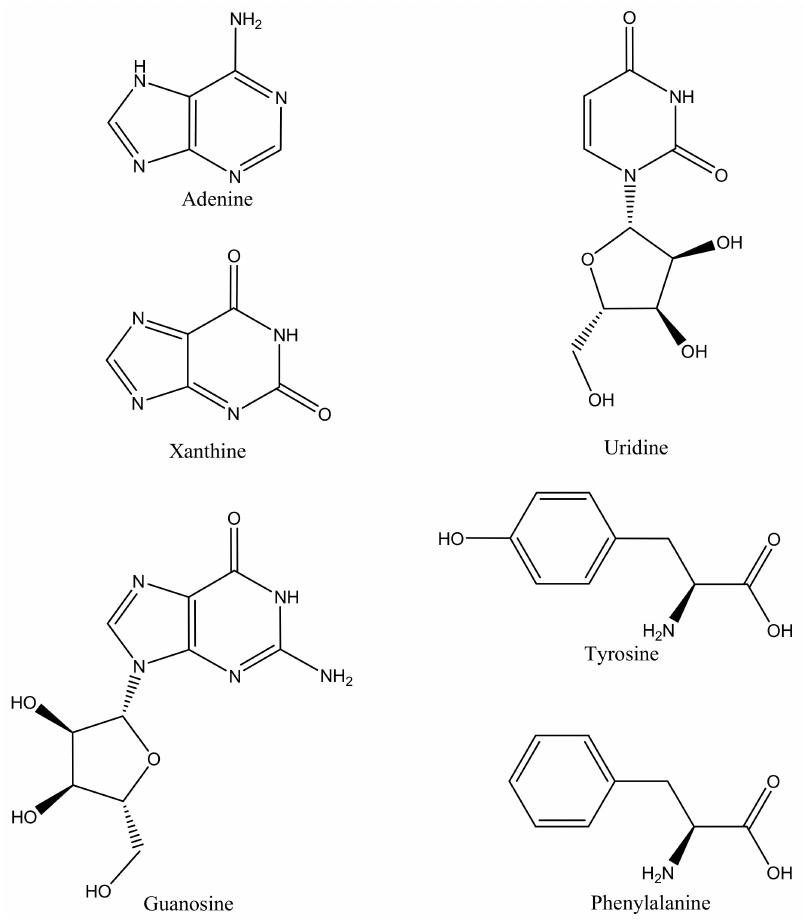
Figure 2. Structures of the nitrogen compounds determined in di ff erent honey